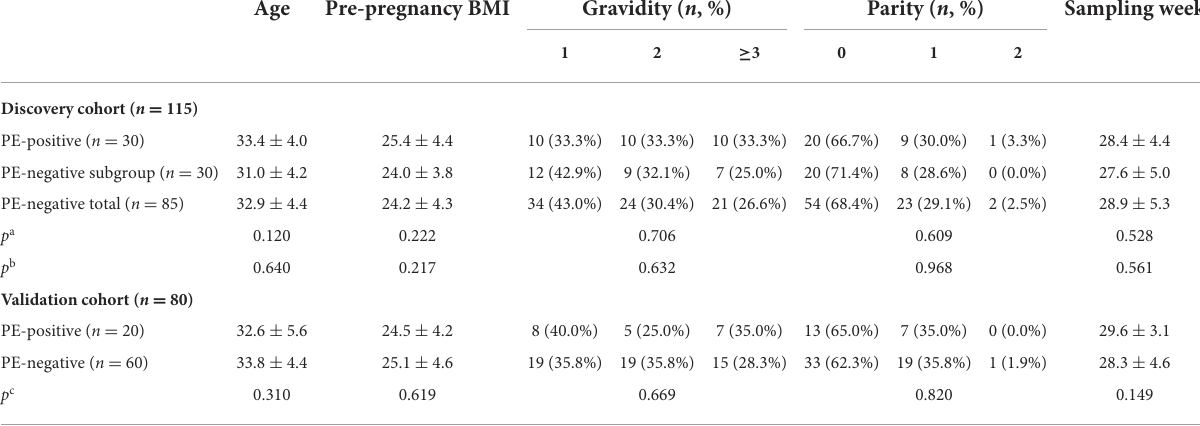
TABLE 1 Demographic information for the discovery cohort and the validation cohort. Age Pre-pregnancy BMI Gravidity ( n , %) Parity ( n ,